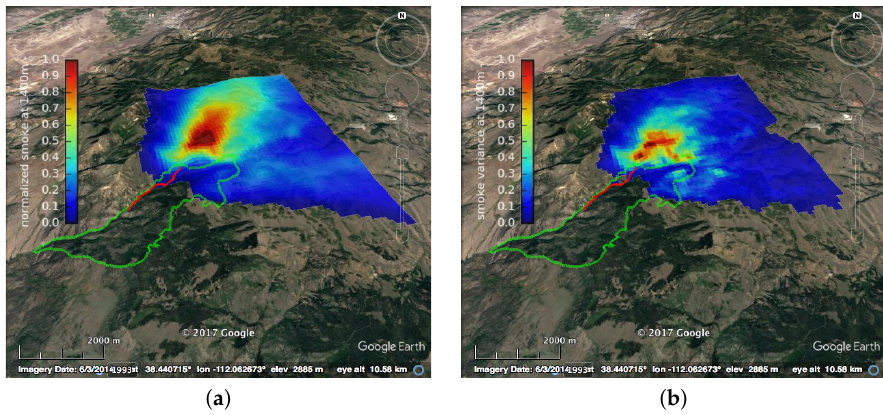
Figure 17. ( a ) The mean normalized smoke concentration at 1400 m above the ground computed from 5 most typical days; ( b ) The normalized average variance of the smoke concentration at 1400 m computed from 5 most typical days. Green contour represents burn unit boundaries, red line shows the ignition.